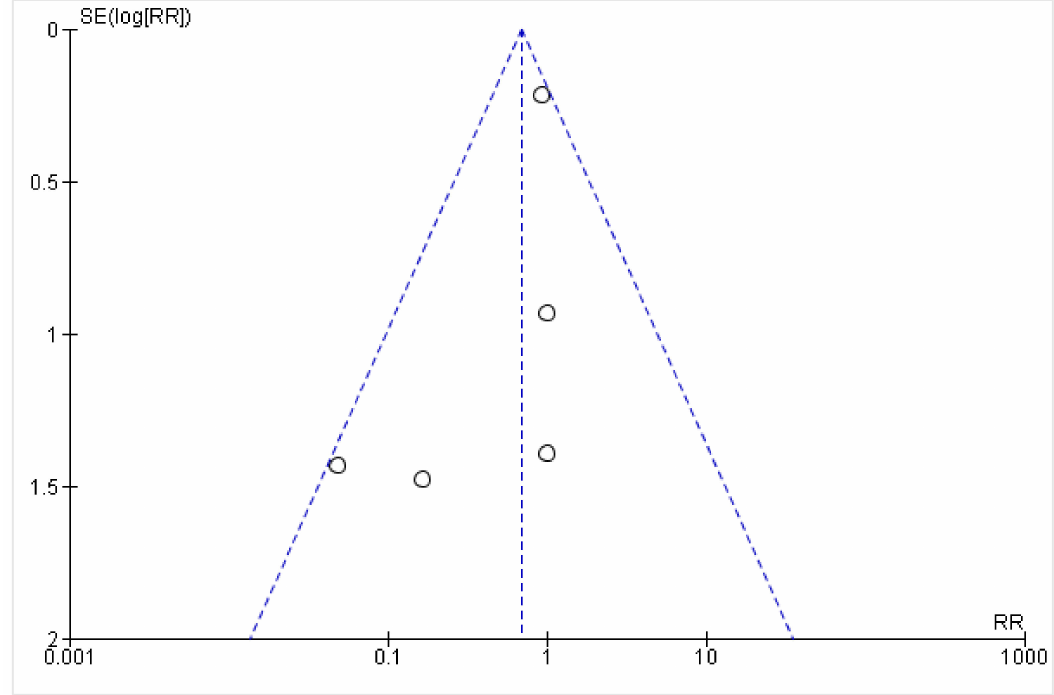
Figure 3. Funnel plot for the visual representation of publication